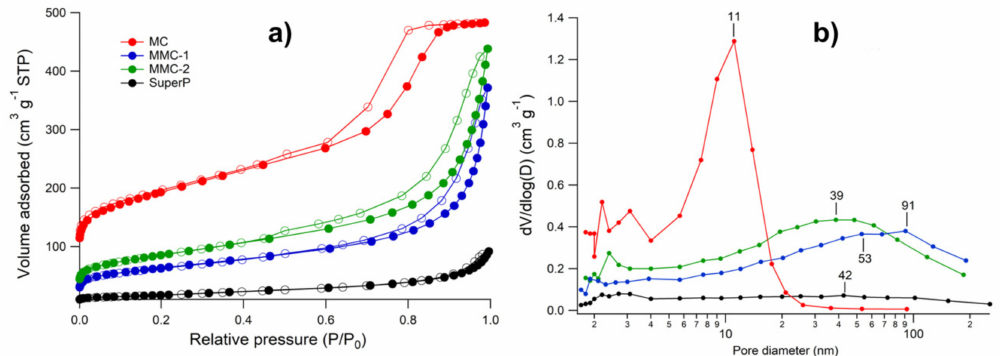
Figure 4. Representative SEM ( Top ) and TEM ( Bottom ) micrographs of MC, MMC-1, MMC-2 and Super P carbons.